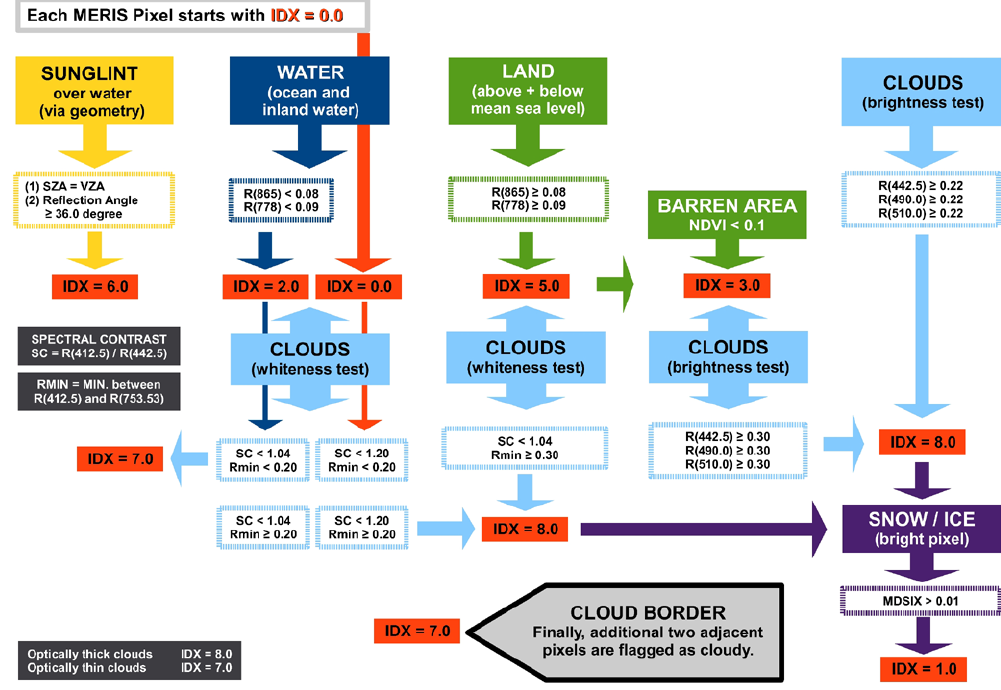
Fig. 3. A scheme illustrating the MERIS pixel classification, based on the threshold method, that is incorporated in the MICROS algorithm. Each MERIS pixels starts with an index value of 0.0 before it passes each step of the MERIS identification routine, where specific conditions are checked in order to provide a certain index (IDX) value. A detailed explanation of the thresholds and constraints used for the pixel classification is given in Sect.